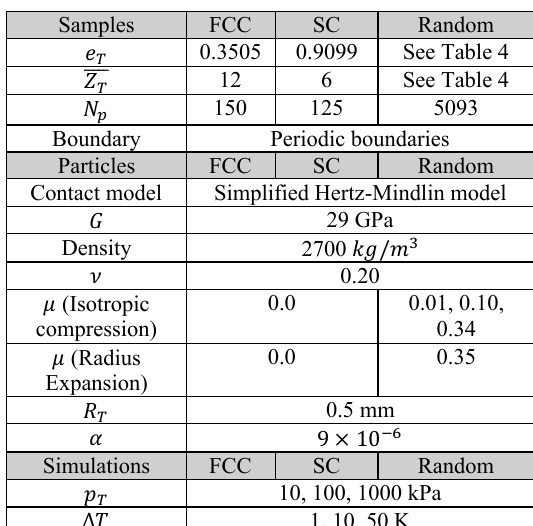
Table 1 . DEM simulation